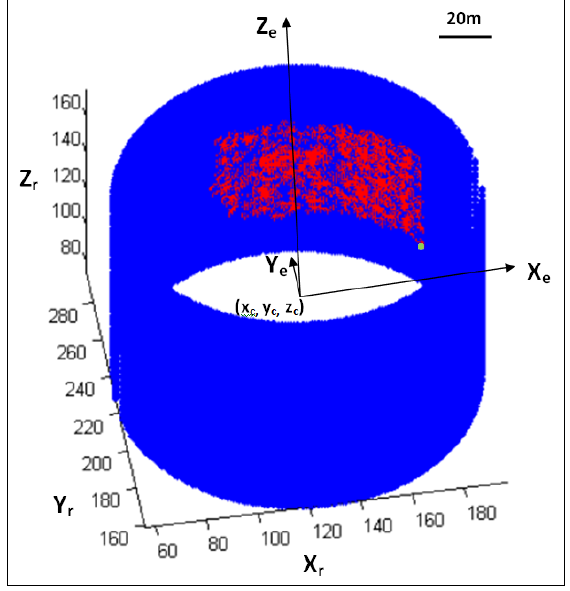
Figure 4. Elliptic cylinder fitting. ( X ( x , y , z ) denotes the center of the elliptic cylinder system, ( X c c c the registered point clouds. The blue section is the fitted elliptic cylinder. The green point situated on the right bottom of the red section was the starting point of the segmentation.